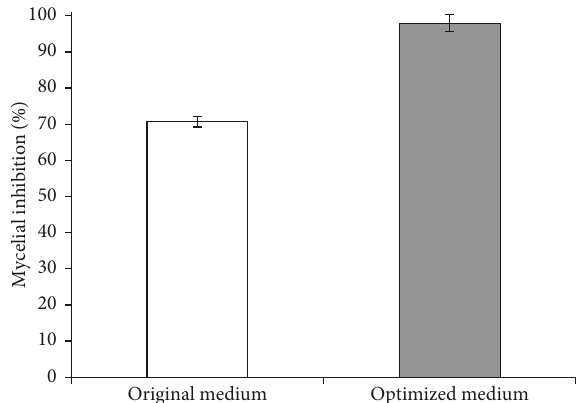
Figure 4: Antifungal activity of X. stockiae PB09 in the original medium and optimized medium.